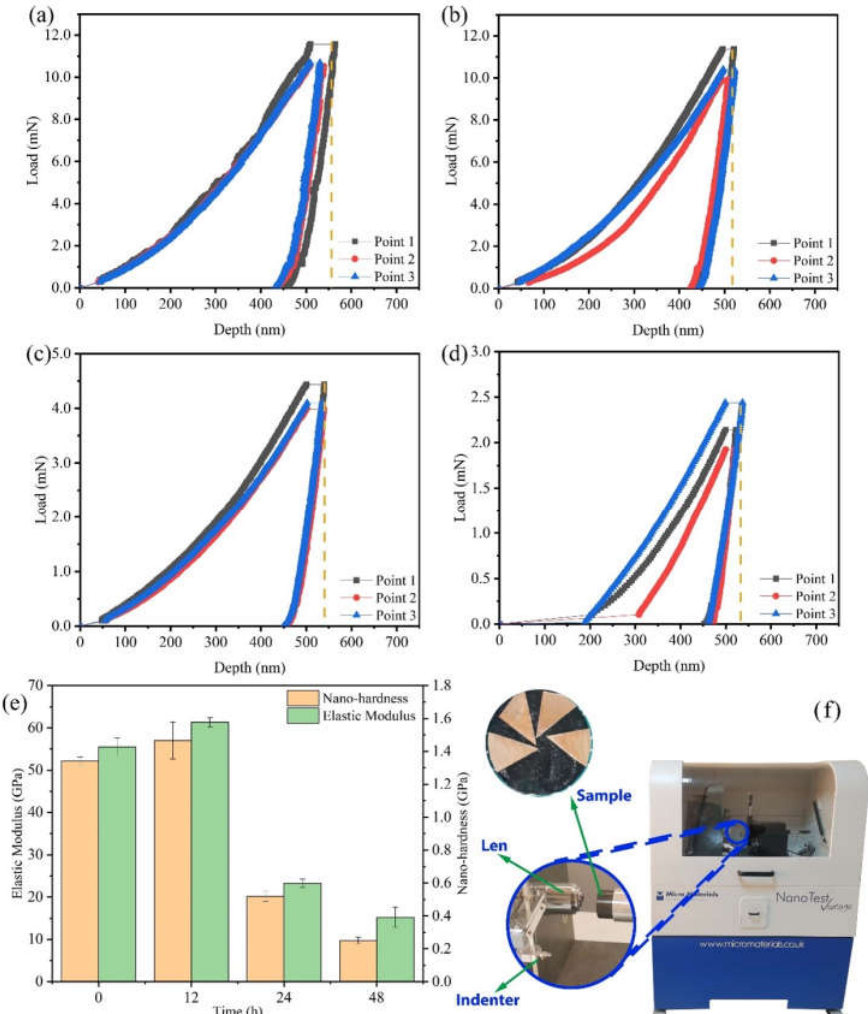
Figure 2. Load–displacement curve of Cu foil treated by DCT for ( a ) 0 h, ( b ) 12 h, ( c ) 24 h, ( d ) 48 h, and ( e ) the results of nano-hardness and elastic modulus on the nano-indentation; ( f ) a picture of the nano-indentation machine.